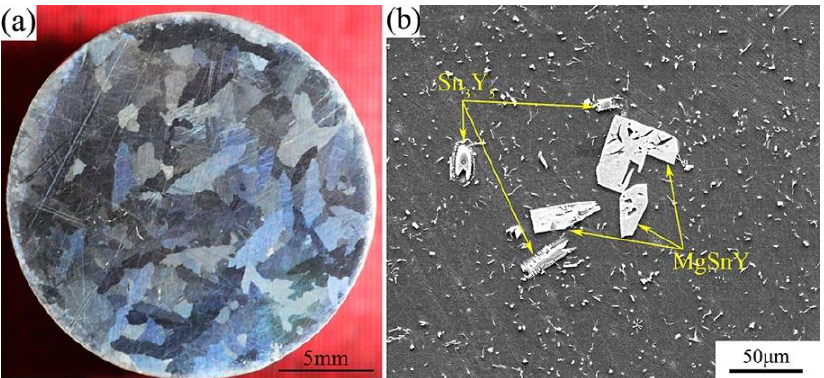
Figure 4. ( a ) Macrostructure and ( b ) microstructure of the Mg-1Sn-2.5Y alloy solidified under 1 atm. The macrostructure and microstructure of the Mg-1Sn-2.5Y alloy solidified at a cooling rate of 10–15 K/s under a pressure of 1 GPa are shown in Figure 5. The macrostructure consists of the outer fine equiaxed zone, the columnar zone, and the coarse equiaxed zone. With the increase in cooling rate, the average grain size decreases (Figure 5a). The second phases are uniformly distributed in the outer fine equiaxed zone and the columnar zone, and the coarse Sn 3 Y 5 and MgSnY phases disappear (Figure 5b,d). This also indicates that the solubility of Sn in the α -Mg matrix increases. The microsegregation occurs in the coarse equiaxed zone, and solute is concentrated in the interdendritic regions. The average secondary dendrite arm spacing is 14–17 µ m. Many precipitates in the microsegregation region weaken the specular reflection and enhance the diffuse reflection, making the microsegregation region in the macrograph darker (Figure 5a,c).